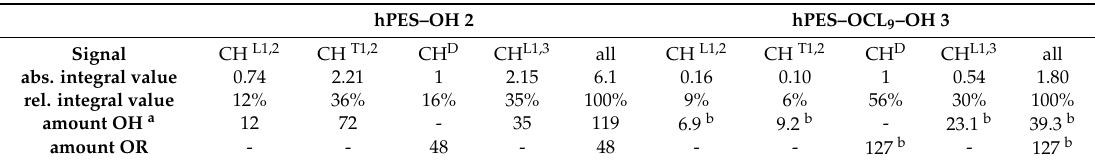
Table A3. Comparison of 13 C NMR spectra of hPES–OH 2 and hPES–OCL 9 –OH 3 as shown in Figure A9 with regard to specific glycerol’s methine signals and calculation of their relative abundance, and absolute and normalized amounts of OH and OR groups for calculation of the degree of functionalization D f